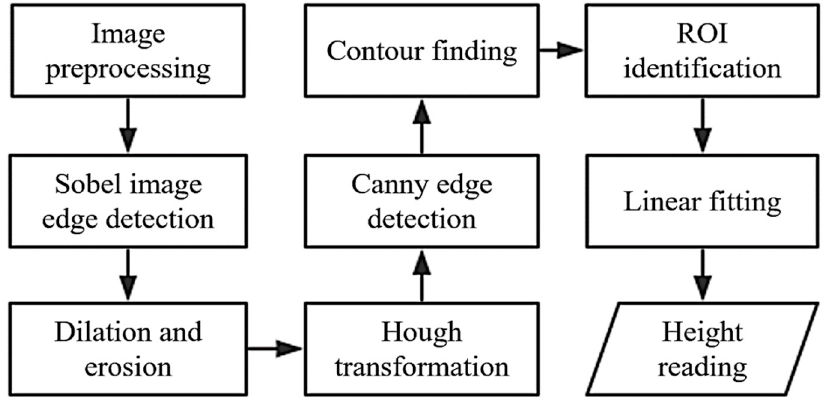
Figure 3. The image processing flow, preprocessing image preprocessing includes gray processing and Gaussian smoothing.